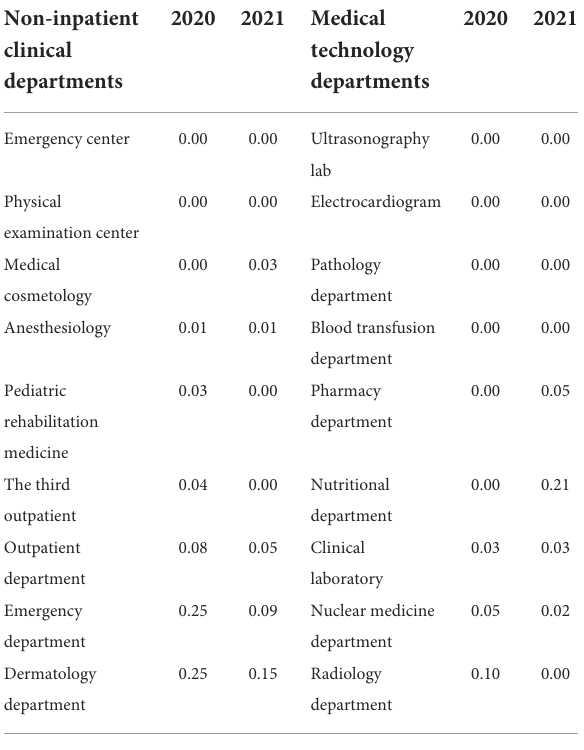
TABLE 7 The average monthly per capital score of non-inpatient clinical departments, medical technology departments in 2020 and 2021 (scores).